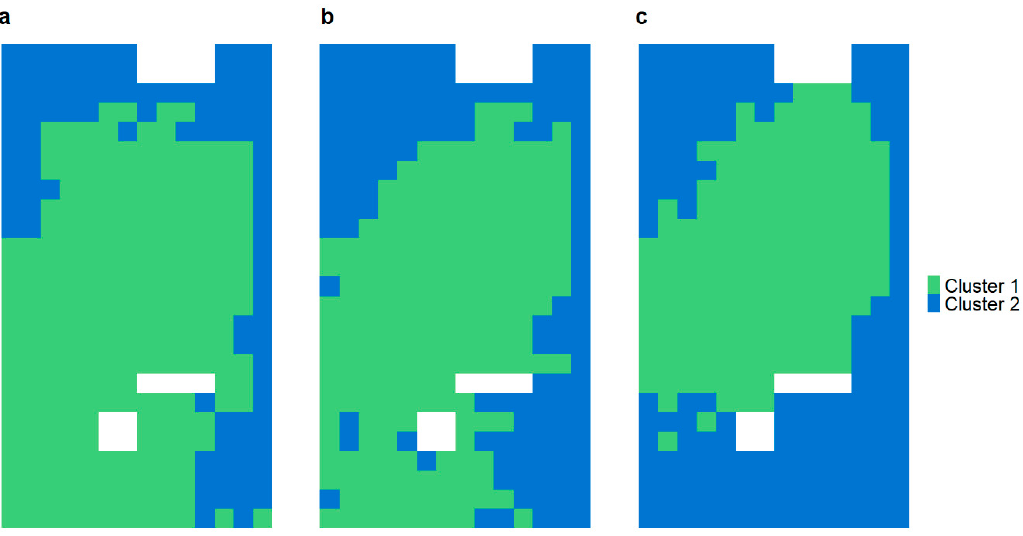
Figure 5. Time-series clustering maps for each of the time-series components: ( a ) trend; ( b ) seasonality; and ( c ) remainder.